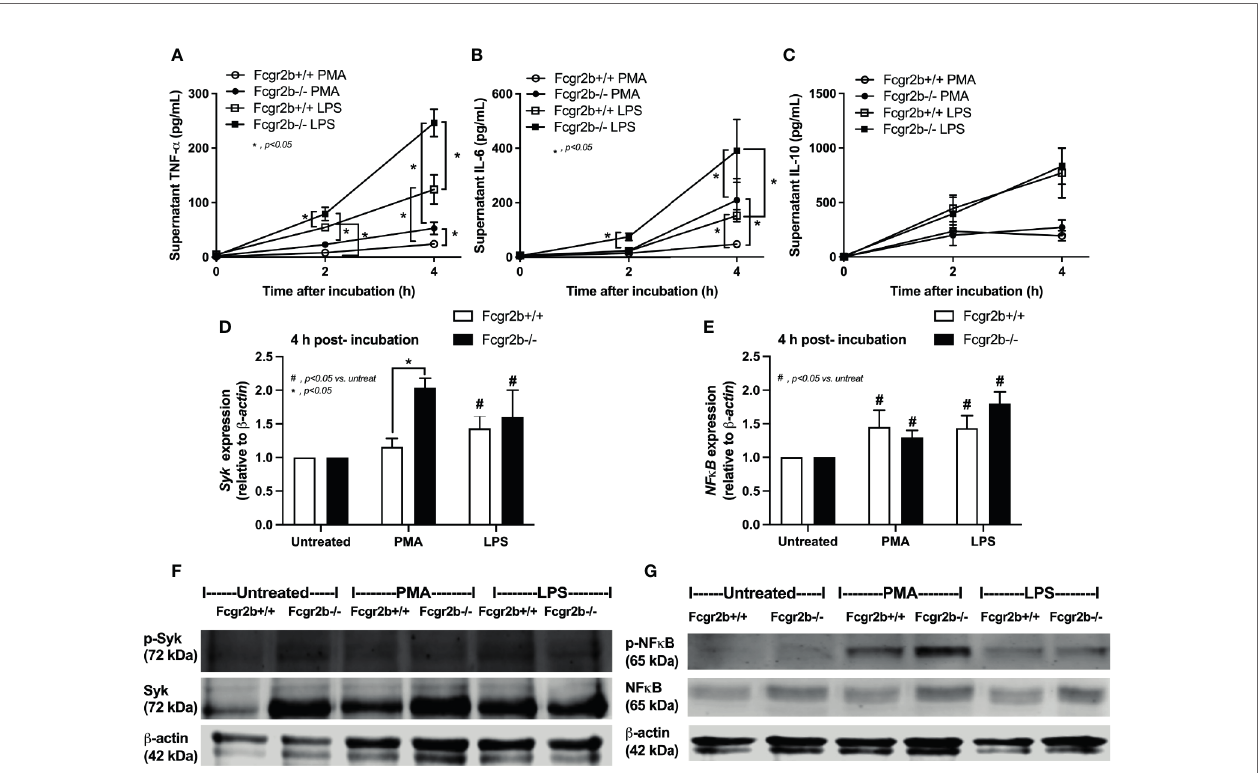
FIGURE 8 | Prominent cytokine production at 4 h through Spleen tyrosine kinase ( Syk ) and nuclear factor kappa B ( NF k B ) in neutrophils of lupus prone mice. Responses of Fcgr2b-/- and wild-type (Fcgr2b+/+) neutrophils after activation by phorbol myristate acetate (PMA), a NETs activator, or lipopolysaccharide (LPS), a TLR-4 stimulator, as evaluated in time-points by supernatant cytokines (TNF- a , IL-6 and IL-10) (A – C) and the downstream signals (at 4 h of the stimulation) in gene expression ( Syk and NF k B ) (D, E) and protein abundances (Syk/phosphorylated-Syk and NF k B/phosphorylated NF k B) with the representative pictures of Western blot analysis (F, G) are demonstrated (independent triplicated experiments were